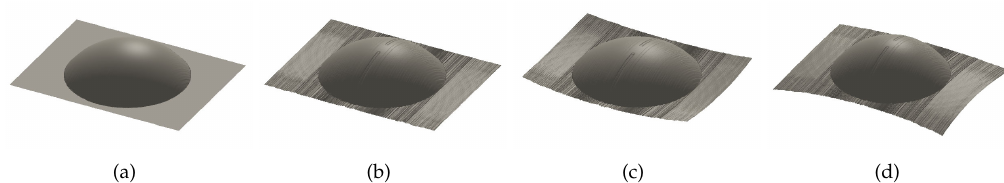
Figure 10. Results of the depth map reconstruction tests based on the specular highlight pixels with different depth estimation precisions in the simulation. ( a ) Ground truth of the object surface. ( b ) Depth map reconstruction results based on the specular highlight pixel with minimal depth estimation error. ( c ) Depth map reconstruction results based on the specular highlight pixel with positive RMS depth estimation error. ( d ) Depth map reconstruction results based on the specular highlight pixel with negative RMS depth estimation error. Table 1. RMSEs of the depth map reconstruction of the object surface in the simulation. Depth Estimation Error of Seed Point